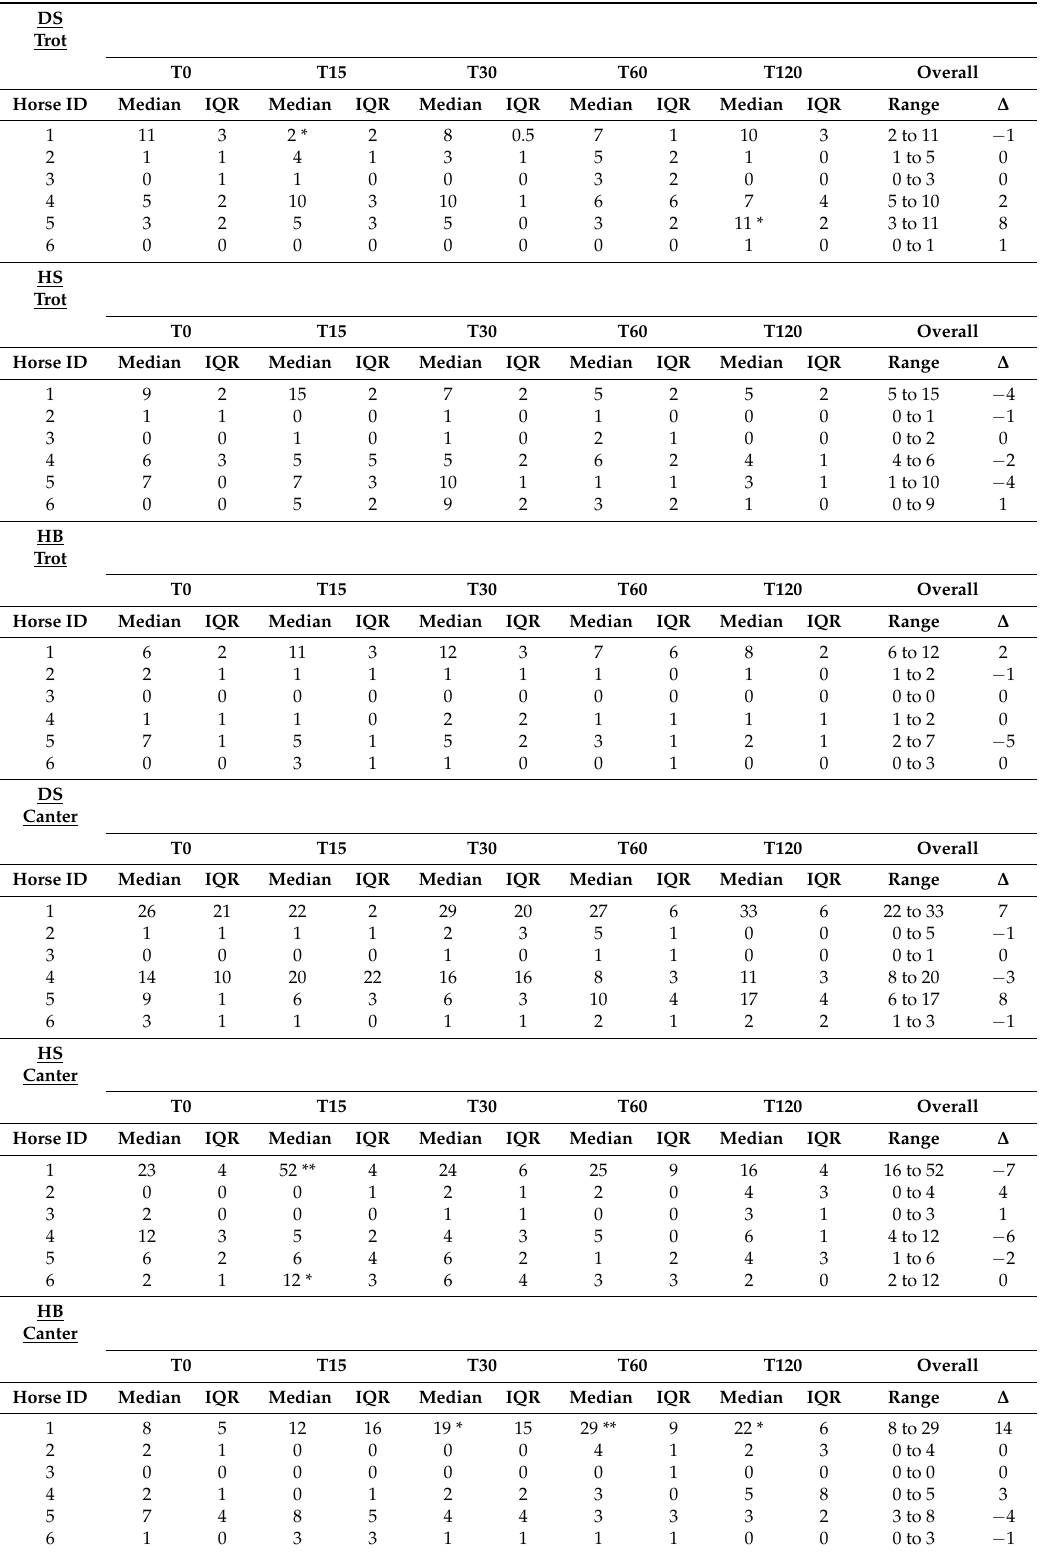
Table 1. Individual headshaking behaviors at the trot and canter across all times and treatments. Median and IQR for the headshakes/minute. ∆ signifies the change from T0 to T120. * signifies a p < 0.05 and ** signifies a p <